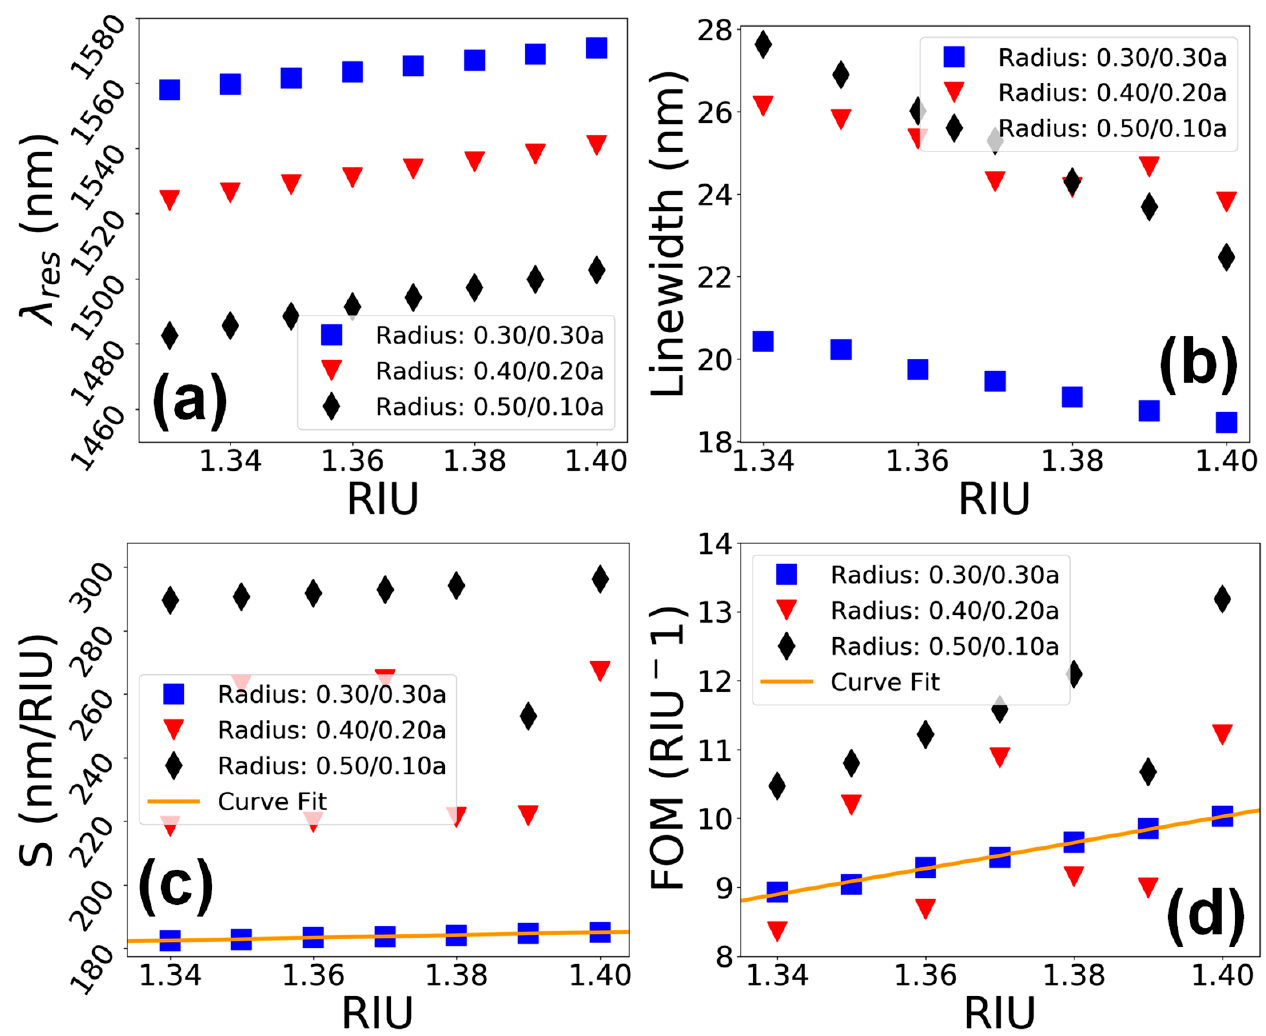
Figure 9. Performance evaluation of the sensor device vs. variation in the shape of PhC elements for hole depth of 𝑑 = 1.5𝑎 . ( a ) 𝜆 (cid:3045)(cid:3032)(cid:3046) vs. RIU. ( b ) Linewidth vs. RIU. ( c ) S vs. RIU. ( d ) FOM vs. RIU. hole depth of d = 1.5 a . ( a ) λ res vs. RIU. ( b ) Linewidth vs. RIU. ( c ) S vs. RIU. ( d ) FOM vs.